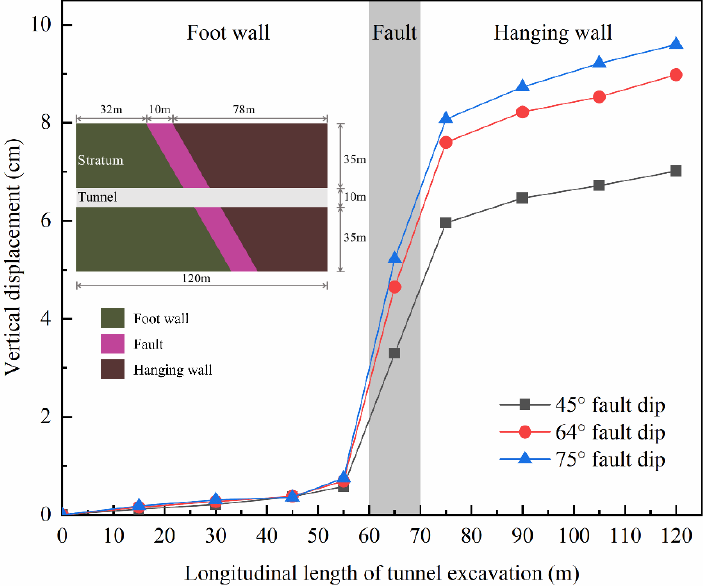
Figure 18. Vertical displacement curve of the lining for different fault dip (the data come from the situation of the 10 cm fault dislocation in [14]).